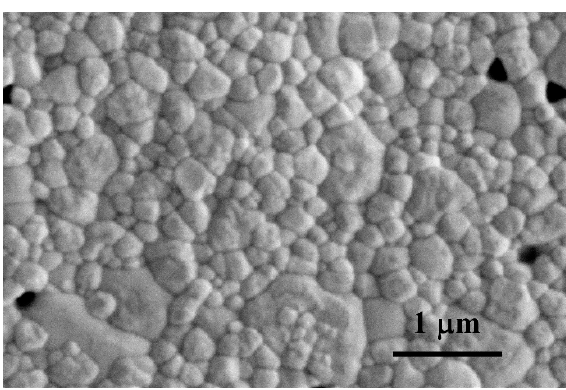
Figure 3. SEM micrograph of the polished c. s. surface of the 3YTZP composite after annealing in air.